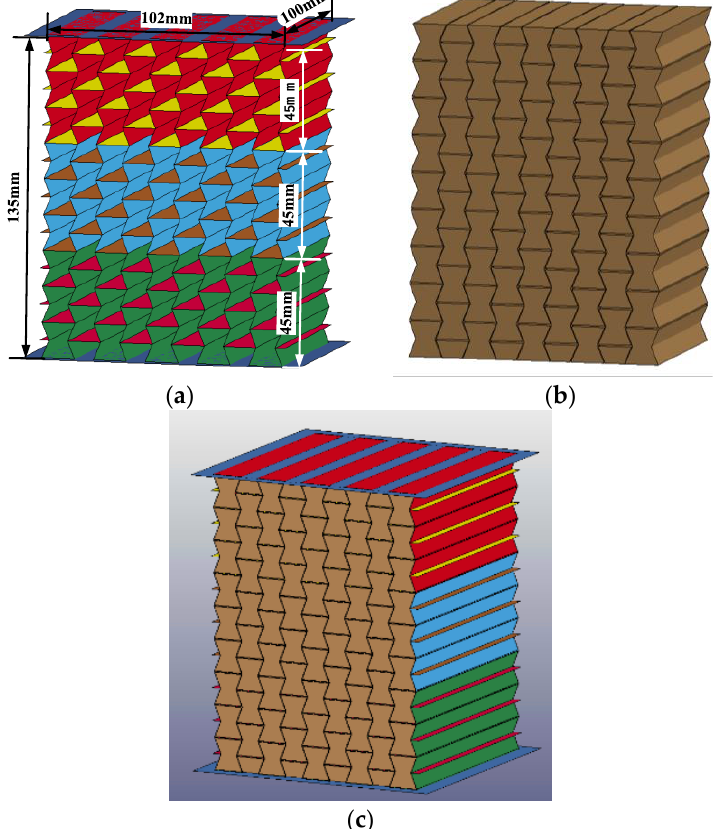
Figure 11. The numerical model of the composite with cell-wall thickness gradient: ( a ) auxetic honeycomb; ( b ) foam concrete filler; ( c ) auxetic honeycomb filled with foam concrete. The average thickness of the single layer of the honeycomb cell wall was set to 0.25 mm, while the thickness of the upper and lower face sheet was set to 0.5 mm, with a plane size of 118 mm × 112 mm. The total mass of the composite was 789 g and its average density was 580 kg/m 3 . In this numerical simulation, three different cell-wall thickness gradients were considered, and the cell-wall thickness of each layer was assigned as 0.2:0.25:0.3, 0.15:0.25:0.35, and 0.1:0.25:0.4, respectively. In addition, the gradient direction was also